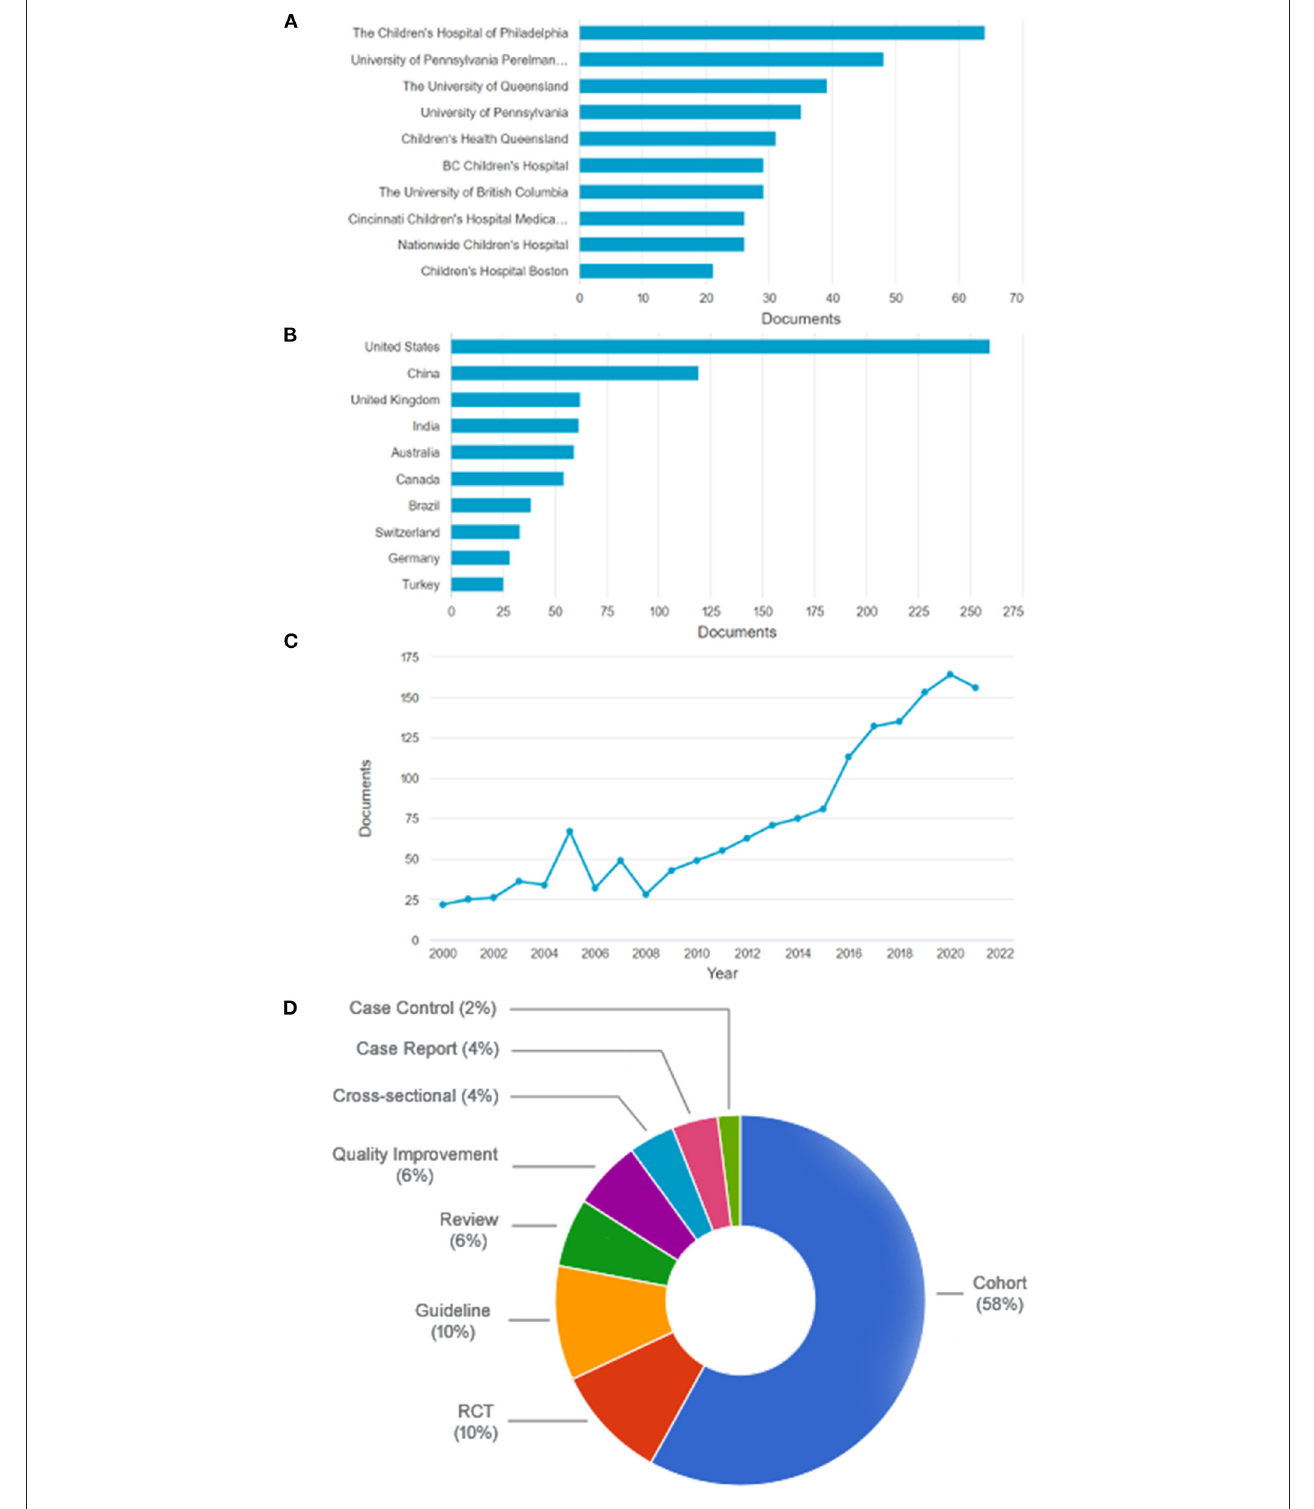
FIGURE 1 | (A) The ten most frequent institutions among the most cited articles in the last 5 years (all from North America or Australia). (B) The ten most frequent countries among the most cited articles in the last 5 years. (C) All articles retrieved sorted by year. (D) Types of articles. RCT, randomized controlled trial. Based on data from Scopus